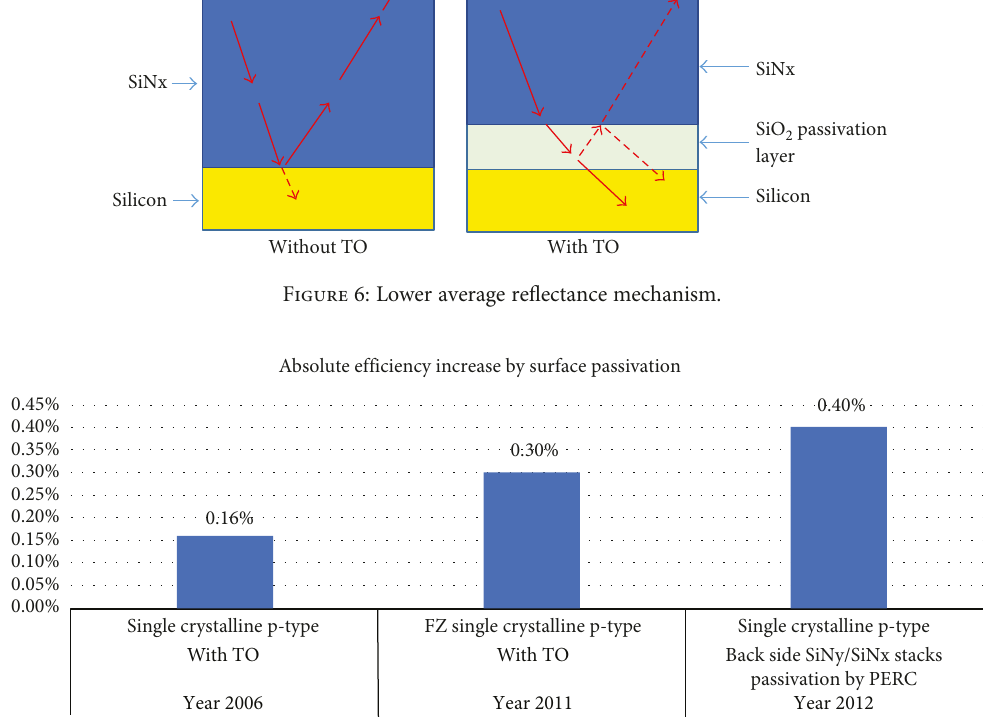
Figure 7: Absolute e ffi ciency increase by surface passivation in single crystalline p-type [24 –